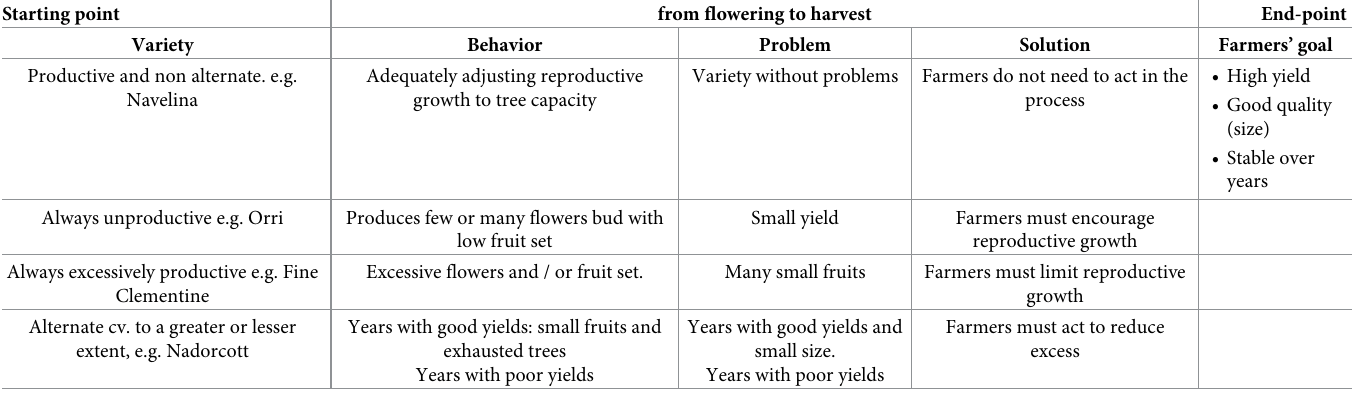
Table 1. Problem scheme according to variety